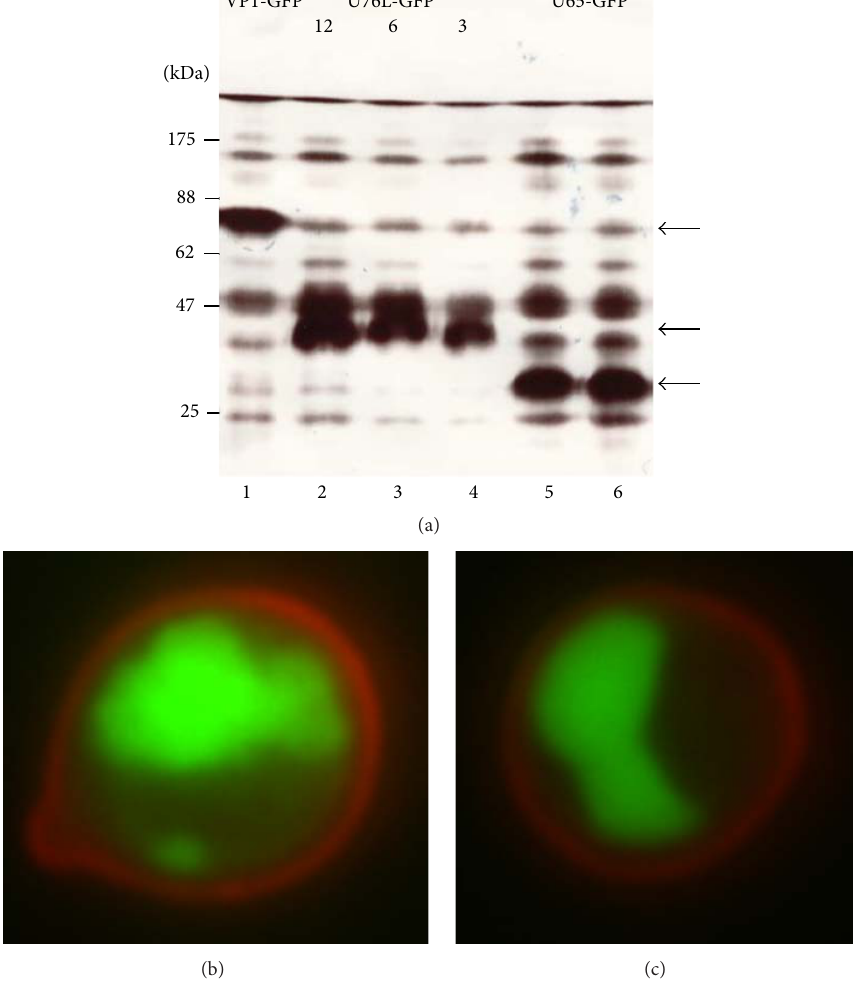
Figure 5: (a) SDS-PAGE of proteins from cells expressing the following: Lane 1, VP1-GFP (70kDa, arrow); Lanes 2–4, U76L-GFP (36.2 kDa, arrow, loads of 12, 6, and 3 𝜇 L, resp.); Lanes 5 and 6, U65-GFP (34.1 kDa, arrow, independent cultures). (b) Fluorescence microscopy of cells expressing U65-GFP. Cell wall glucan is stained by Congo red. (c) pH 11.5